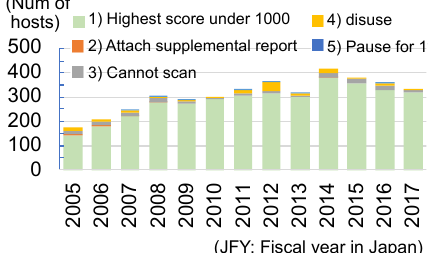
Figure 6: Flowchart of the helper for database schema modification Figure 8: Report submissions in the security self-inspection, from 2005 to 2017